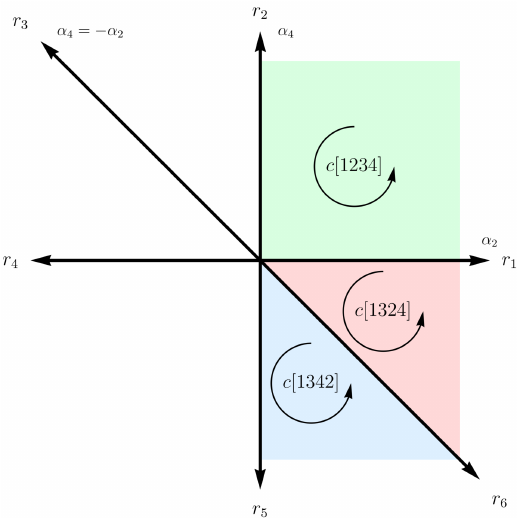
Figure 6 . The three positive sectors c [1234] , c [1324] , c [1342] appearing in the U(1) decoupling relation (5.7a).